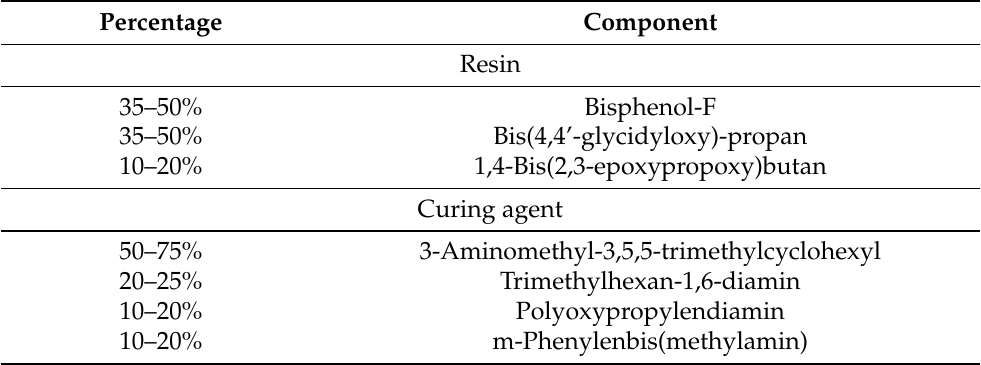
Table 3. Components of the RIMR 426 resin with RIMH 435 curing